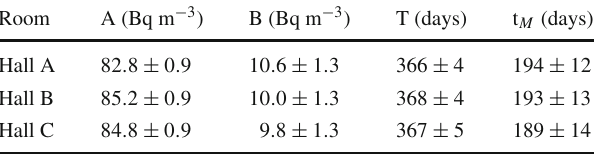
Table 4 Values of the fitted parameters of the 222 Rn concentration of the years 2013–2018 to Eq. (2). The maxima are in mid-July